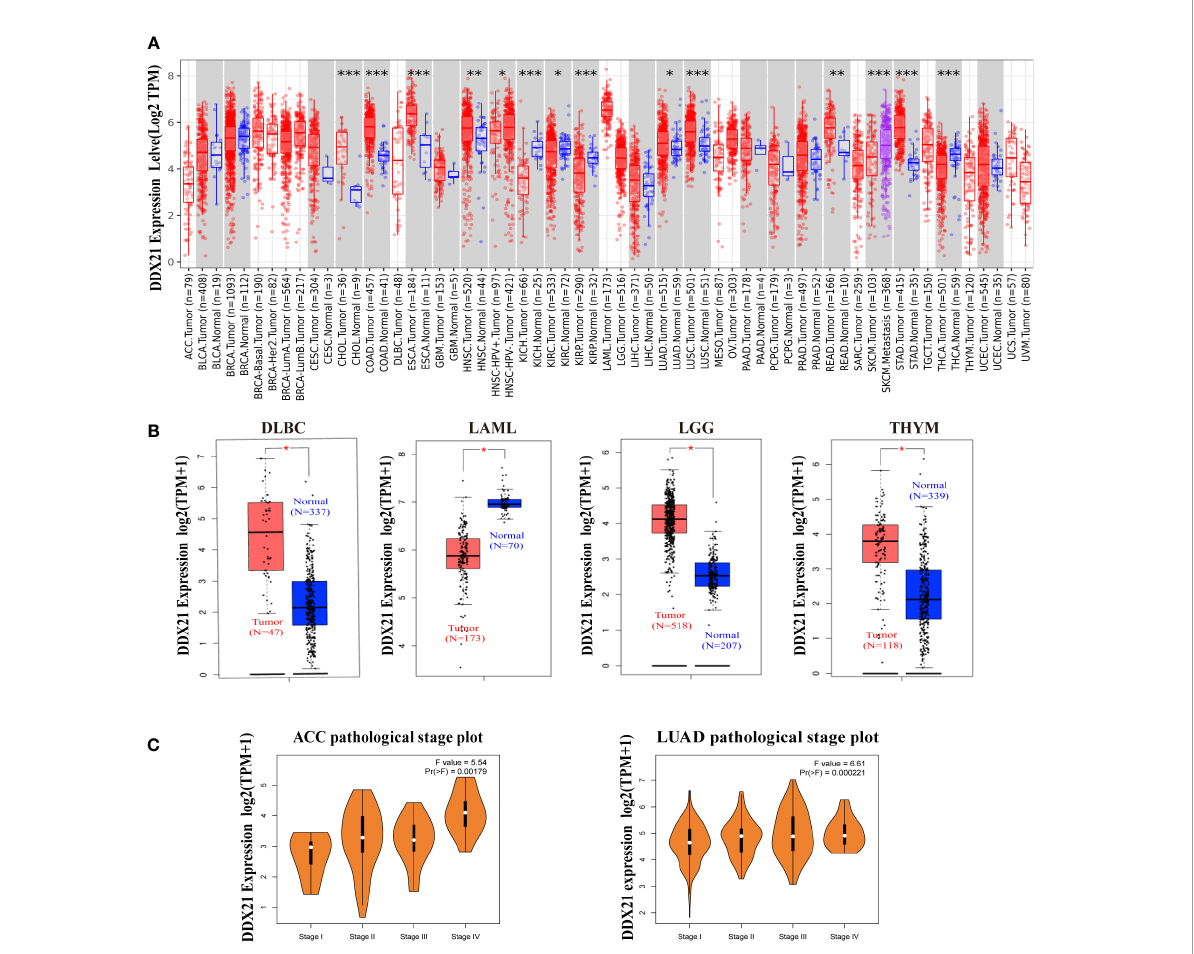
FIGURE 1 Expression levels of the DDX21 gene in different tumors and pathological stages. (A) Expression status of the DDX21 gene in different cancers or speci fi c cancer subtypes analyzed by TIMER2 (*p < 0.05; **p < 0.01; ***p <0.001). (B) For DLBC, LAML, LGG, and THYM in TCGA, the corresponding normal tissues in the GTEx database were included as controls. Boxplot data were supplied (*p <0.01). (C) Based on TCGA data, expression levels of the DDX21 gene were analyzed based on the main pathological stages (I, II, III, and IV) of ACC and LUAD. Log2 (TPM + 1) was applied for log